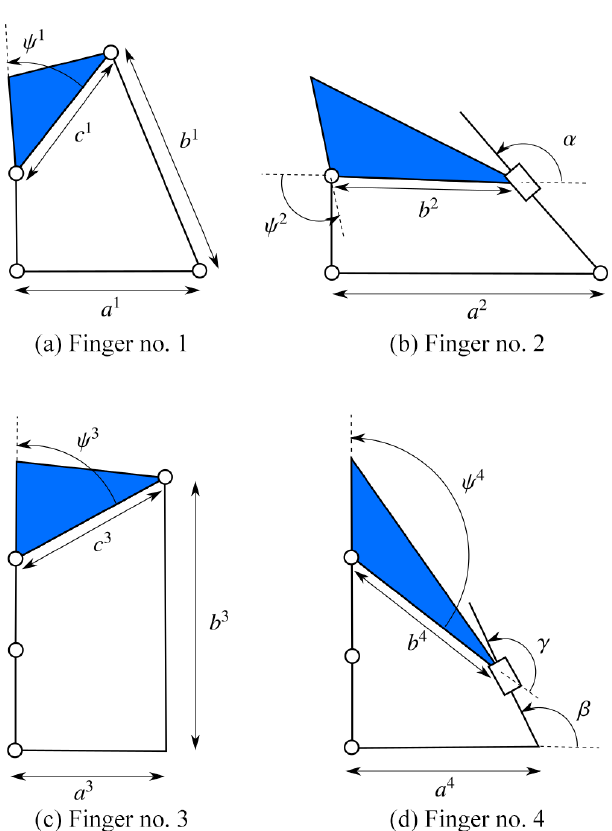
The lower bound of b 3 is the sum of the lengths of the two phalanges in their upright position. ; π ] , [ 0 ; π ] , [ 0 ; π ] The lower bound of β is π for better 2 2 compactness of the geometry of the finger.